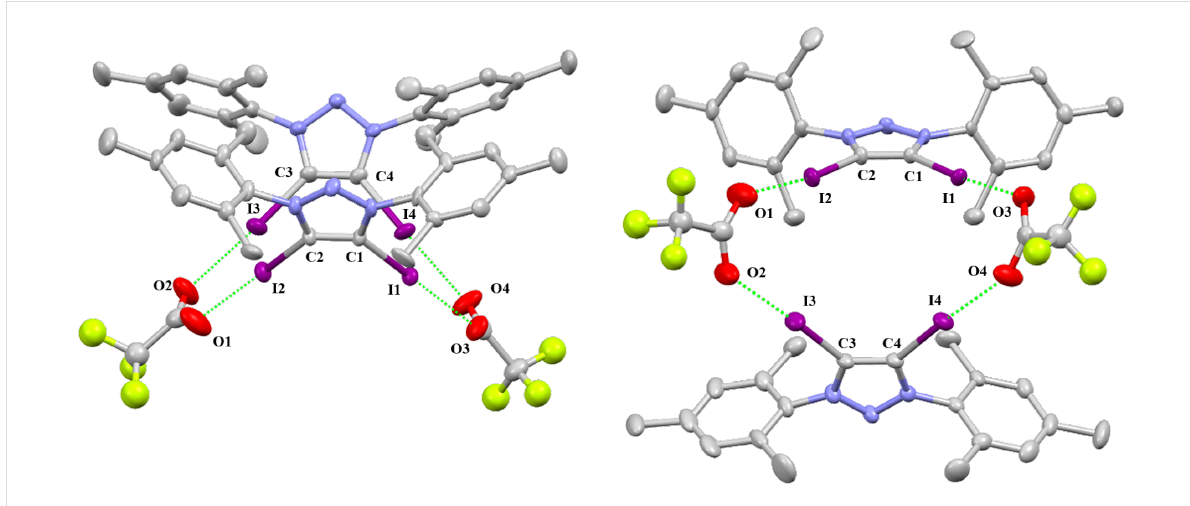
Figure 5: Packing structure of 2-TFA . Hydrogen atoms and disorder of fluorine atoms have been omitted for clarity. Side view (left) and top view (right).